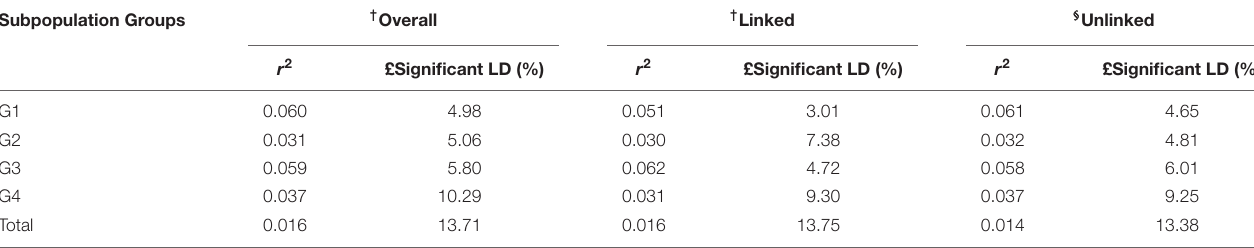
SQR, shan qui red; † Numbers in parentheses are standard deviations. TABLE 6 | Whole genome level LD in the entire panel and the subpopulations obtained from the structure output. Subpopulation